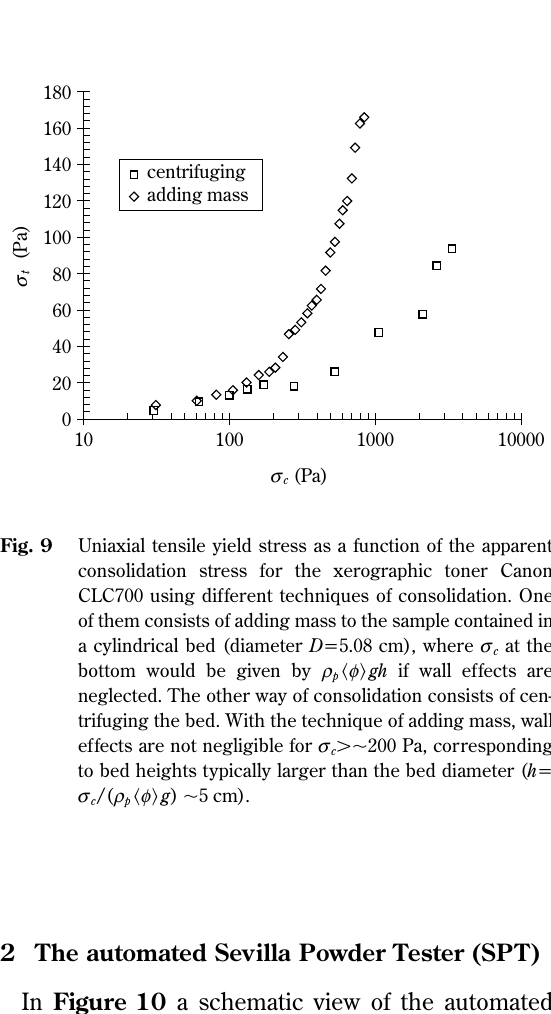
(cid:2) f (cid:3) gh and ∆ p is the downward-directed where W (cid:2) r p 0 gas pressure drop. Further increasing the compress- ing gas flow imposes further pressure on the sample.